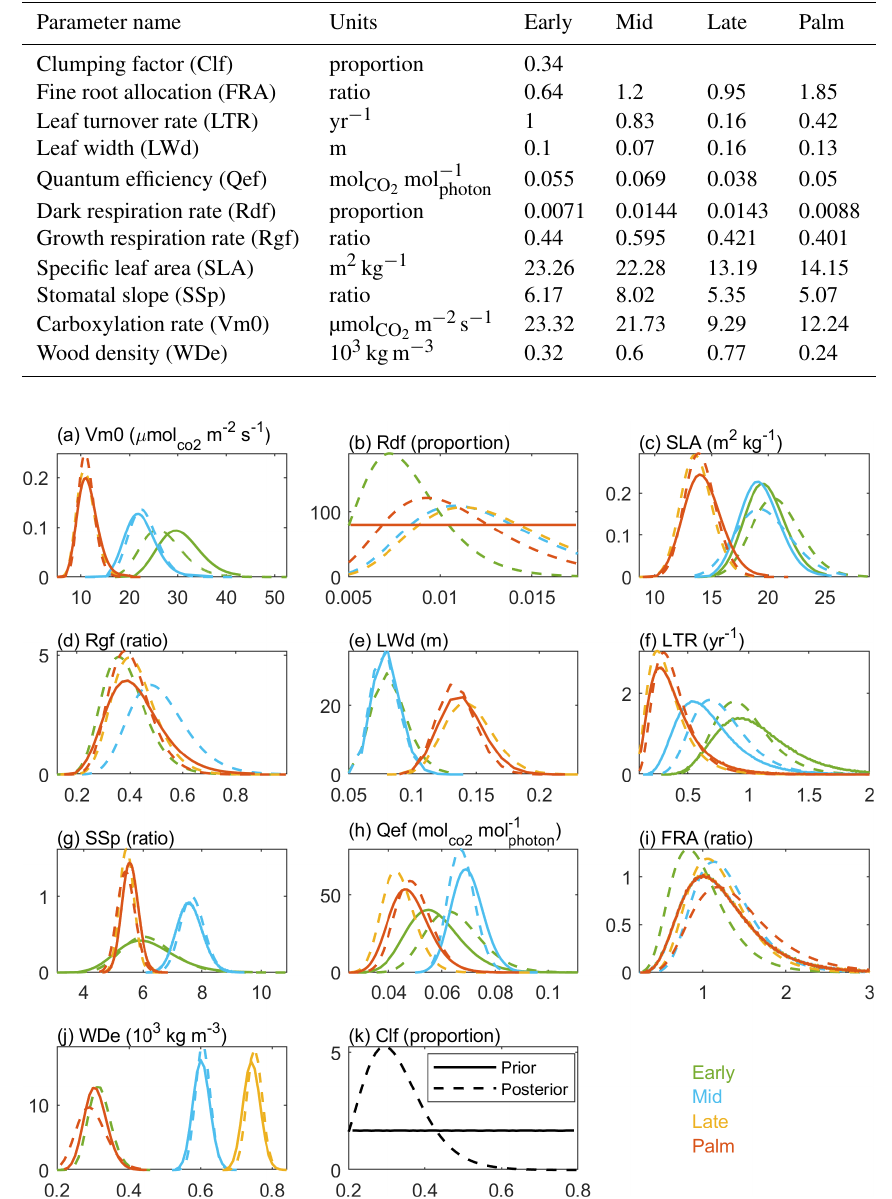
Figure 6. The prior (solid line) and posterior (dashed line) probability density functions for the four PFTs (colors) of the 11 parameters. The first 10 parameters are PFT-dependent, and the last one leaf clumping factor (Clf) is PFT-independent. Palm has the same prior distribution as Late for all parameters except that the wood density (WDe) of Palm has the same prior distribution as that of Early. The long name of each parameter is shown in Table